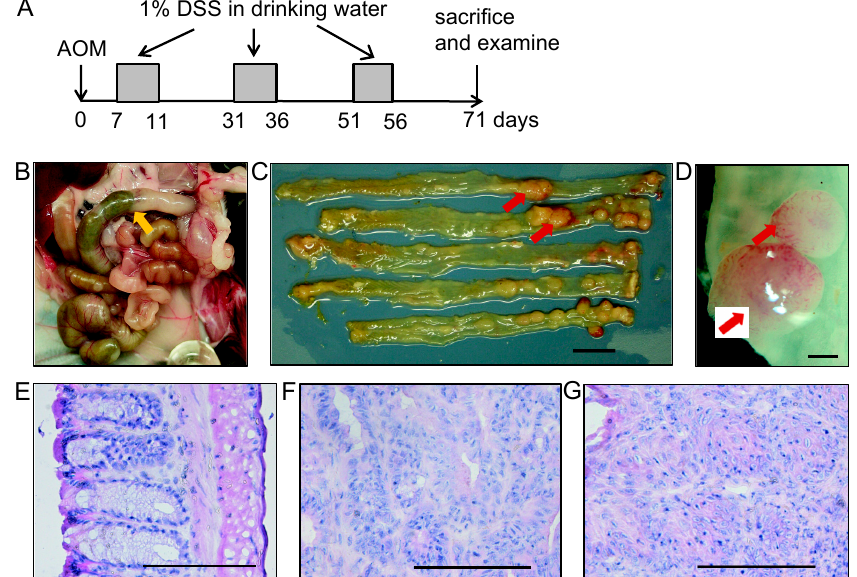
Figure 1. Gross pathology and histopathology of colitis ‐ associated colorectal tumor induced by azoxymethane ‐ dextran sulfate sodium (AOM ‐ DSS) in MUC1.Tg mice. ( A ) Experimental protocol. Azoxymethane (AOM) was injected at 10 mg/kg body weight in the intraperitoneal site, followed by periodical administration of 1% ( w / v ) dextran sulfate sodium (DSS) in drinking water. Mice were sacrificed two weeks after the last DSS administration. ( B ) Colon position in the mouse abdomen as indicated by the yellow arrow. ( C,D ) Tumors developed as pedunculated nodules observed in the distal part of the colon as indicated by red arrows. ( C ) Gross pathological appearance of colorectal tumors showed pale to reddish polypoid nodules in the colorectal site. Histopathological analysis was performed on H&E ‐ stained sections. Representative histopathological images of ( E ) normal co ‐ lon, ( F ) tubular adenoma, and ( G ) squamous metaplasia of AOM ‐ DSS ‐ treated MUC1.Tg mice. Im ‐ ages in (E − G) were captured at ×200 magnification. Scale bars show ( C ) 10 mm, ( D ) 1 mm, and ( E − G ) 100 μ m. Some tumors were tubular adenomas with various grades of dysplasia (Figure 1F). Another type of tumor observed was squamous metaplasia with atypia, which was char ‐ acterized by a stratified squamous epithelium that developed in the colorectal area (Figure 1G). MUC1 expression has been reported in human colon adenoma and adenocarcinoma, but not in normal colonic epithelia [16,56]. We hypothesized that AOM ‐ DSS treatment could induce MUC1 ‐ expressing colorectal tumor formation in MUC1.Tg mice. Therefore, we performed immunohistochemical analysis in non ‐ vaccinated MUC1.Tg mice to con ‐ firm MUC1 expression in AOM ‐ DSS ‐ induced colorectal tumors by using anti ‐ MUC1 an ‐ tibodies (Abs) with different specificities. Anti ‐ MUC1 CTP Ab recognizes the MUC1 cy ‐ toplasmic tail regardless of glycosylation status [57]. Monoclonal Ab MY.1E12 recognizes sialyl ‐ T MUC1 [58,59]. The binding of HMFG1 mAb to the PDTR epitope in MUC1 is par ‐ tially influenced by certain nearby glycans [59], while the binding of HMFG2 mAb to MUC1 is glycosylation ‐ independent [59]. The results showed that various MUC1 gly ‐ coforms were expressed in AOM ‐ DSS induced tumors (Figure 2A). MUC1 was expressed mostly along the apical membrane of adenomatous cells (Figure 2A,f,g,h). However, in squamous metaplasia, MUC1 was highly expressed, not only in the apical part of tumor cells but also on the whole cell surface and in the cytoplasm (Figure 2A,k,l,m). The staining intensity of all anti ‐ MUC1 Abs was stronger in squamous metaplasia tumors than in col ‐ orectal adenoma tumors (Figure 2A − E).